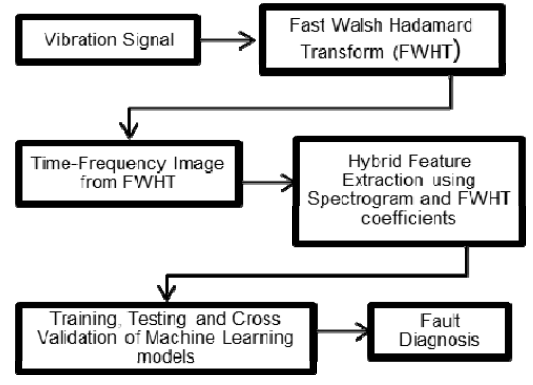
Figure 1. Flowchart for fault diagnosis methodology 2. FAST WALSH HADAMARD TRANSFORM (FWHT) Fast Walsh-Hadamard transform can be applied in different fields of engineering like data compression,